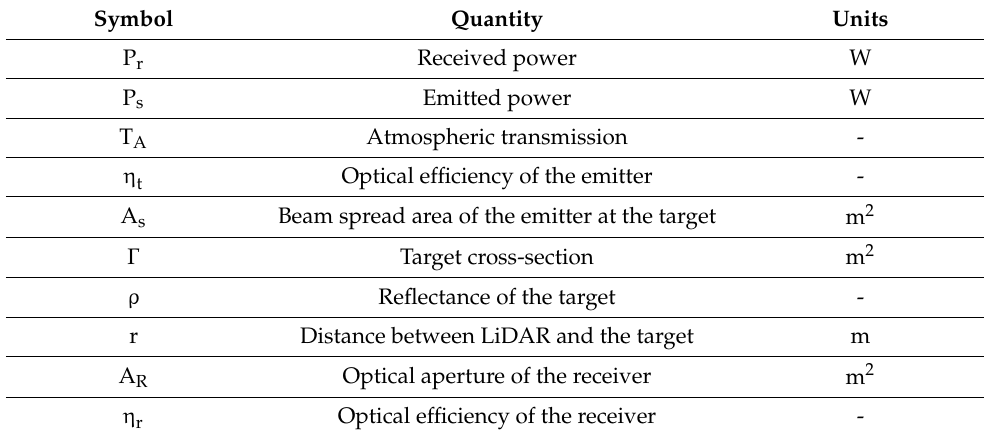
Table 1. List of main variables in Equation